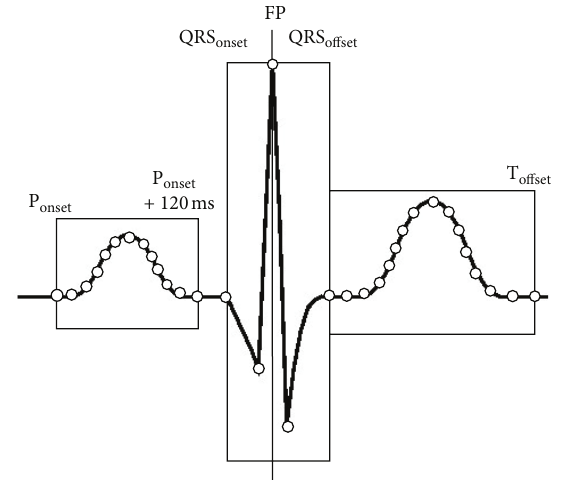
Figure 2: Extraction of ECG morphological features from a heart- beat, where the fiducial point (FP) represents the position of R peak.